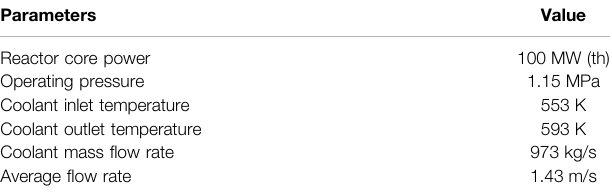
TABLE 2 | Parameters at steady-state operation.